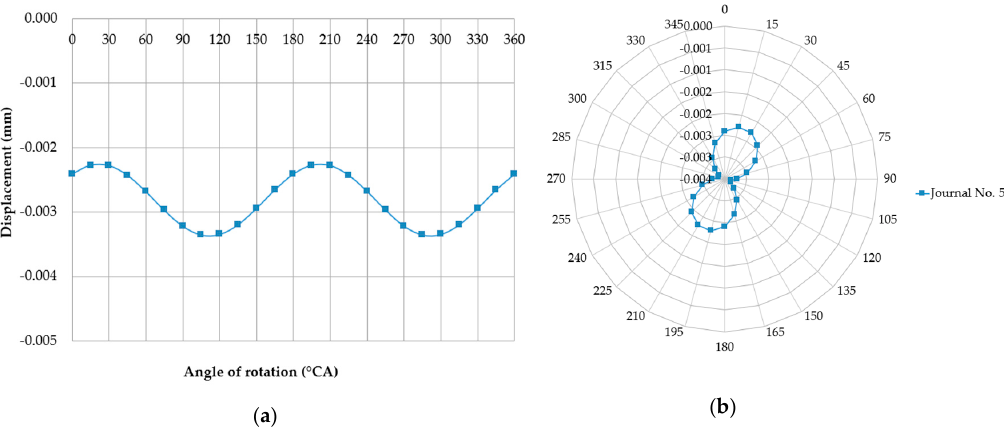
Figure 9. Changes in deflections measured in the vertical plane at individual main journals with the shaft rotated by 15° at a time and when one of the supports (of journal no. 5 counting from the timing gear end) was offset downwards by 0.03 mm relative to the others, in the ( a ) Cartesian and ( b ) polar coordinate systems.